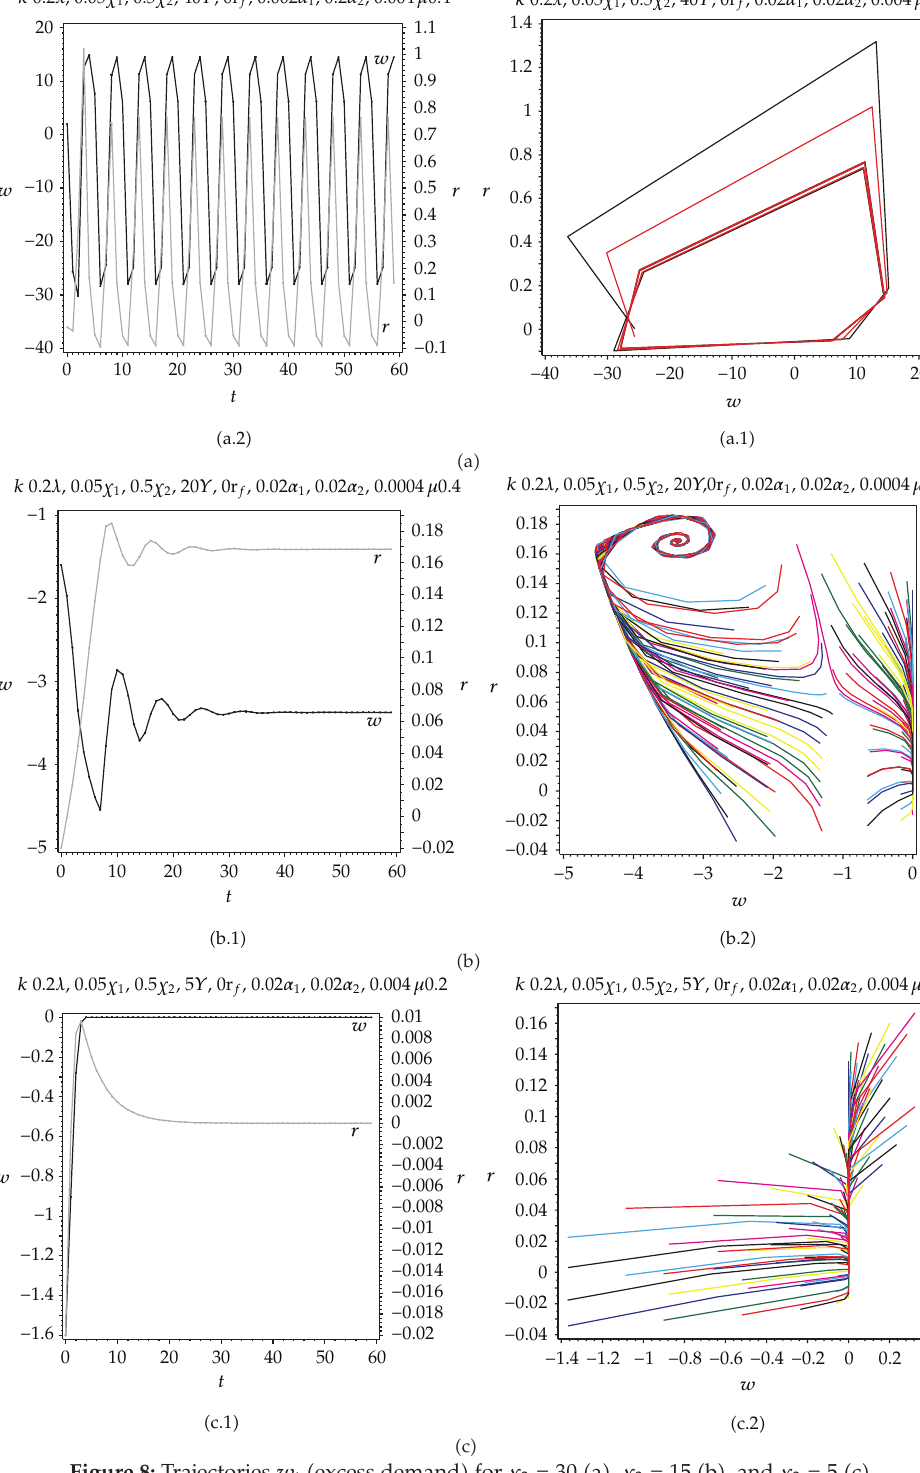
Figure 8: Trajectories w t (cid:3) excess demand (cid:6) for χ 2 (cid:7) 30 (cid:3) a (cid:6) , χ 2 (cid:7) 15 (cid:3) b (cid:6) , and χ 2 (cid:7) 5 (cid:3) c (cid:6)